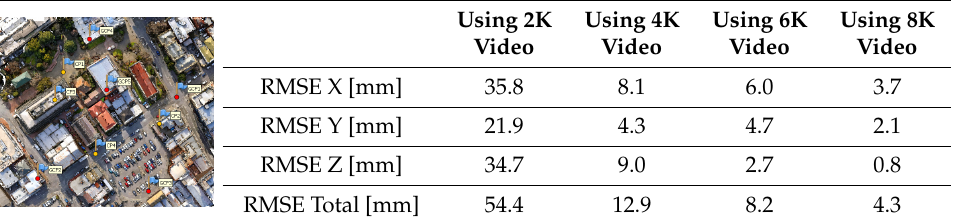
Figure 11. The top view of the checkpoints and GCPs exaggerated error ellipses visualization of the area in the first test at the four drone video resolutions. The error in Z is represented by ellipse color while XY errors are represented by ellipse shape using the Metashape tool.